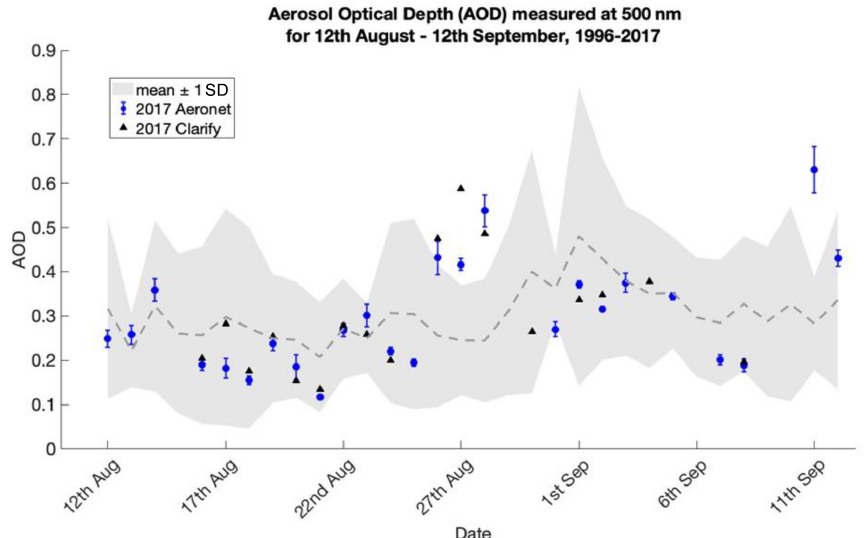
Figure 8. AERONET and CLARIFY daily average AOD data, measured at 500nm, plotted for the period 12 August–12 September 2017. The data from each year are represented by a different colour, with 2017 data shown in black circles. The CLARIFY data, measured with a Microtops sun photometer, are represented by the black triangles, while AERONET data from the ARM Mobile Facility are plotted in blue. The mean of data (1996–2016) is shown by the dashed line, with the grey shaded area representing ± 1 SD (standard deviation). The vertical lines on the ARM Mobile Facility AOD data shows ± 1SD of these